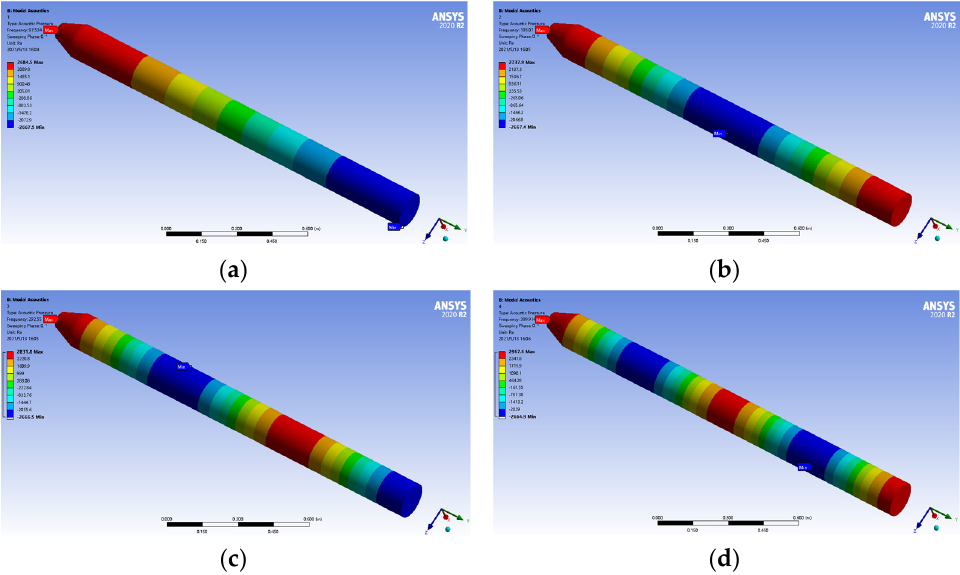
Figure 10. Amplitude-frequency characteristic curves at different positions of the cylindrical acoustic cavity.